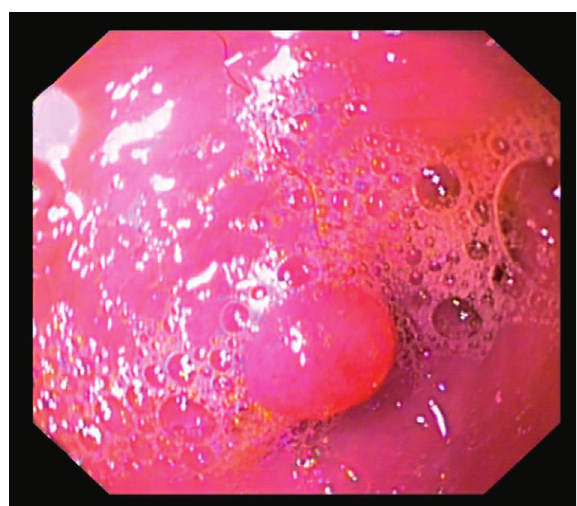
Figure 4: The endoscopic view of adenocarcinoma in canine